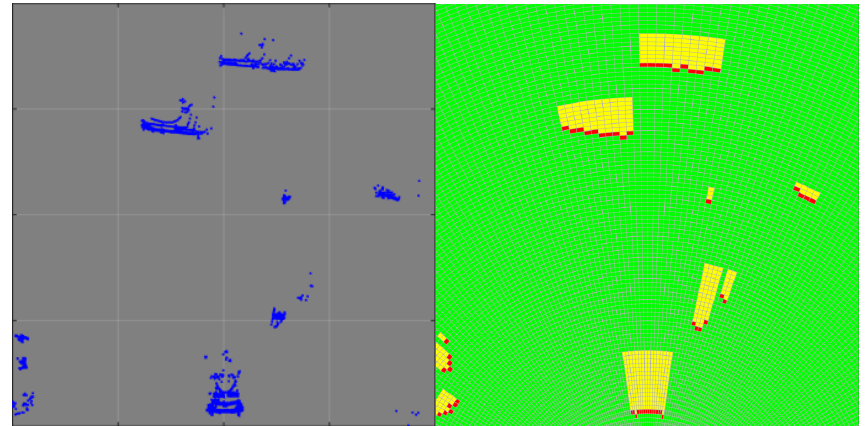
Figure 6. Virtual-scan mapping. ( left ) Point-clouds; ( right ), corresponding virtual scan. States of grids in green, red, and yellow are free, occupied, and occluded,